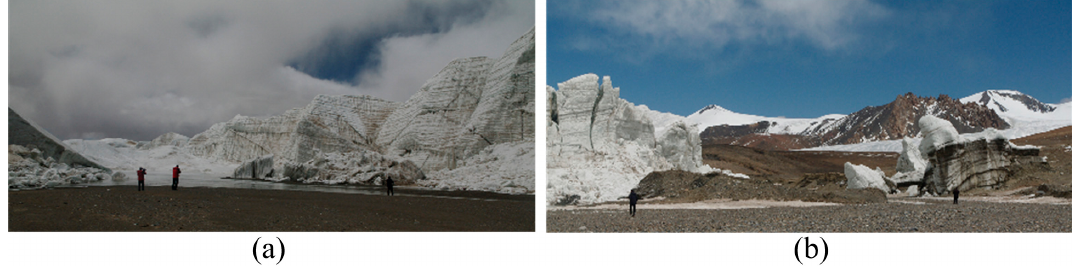
Figure 5. Melt ‐ water and ice cracking at the glacier snout (No. 5Z611A0008) recorded in 2011. ( a ) View from the eastern side; ( b ) view from the western side.